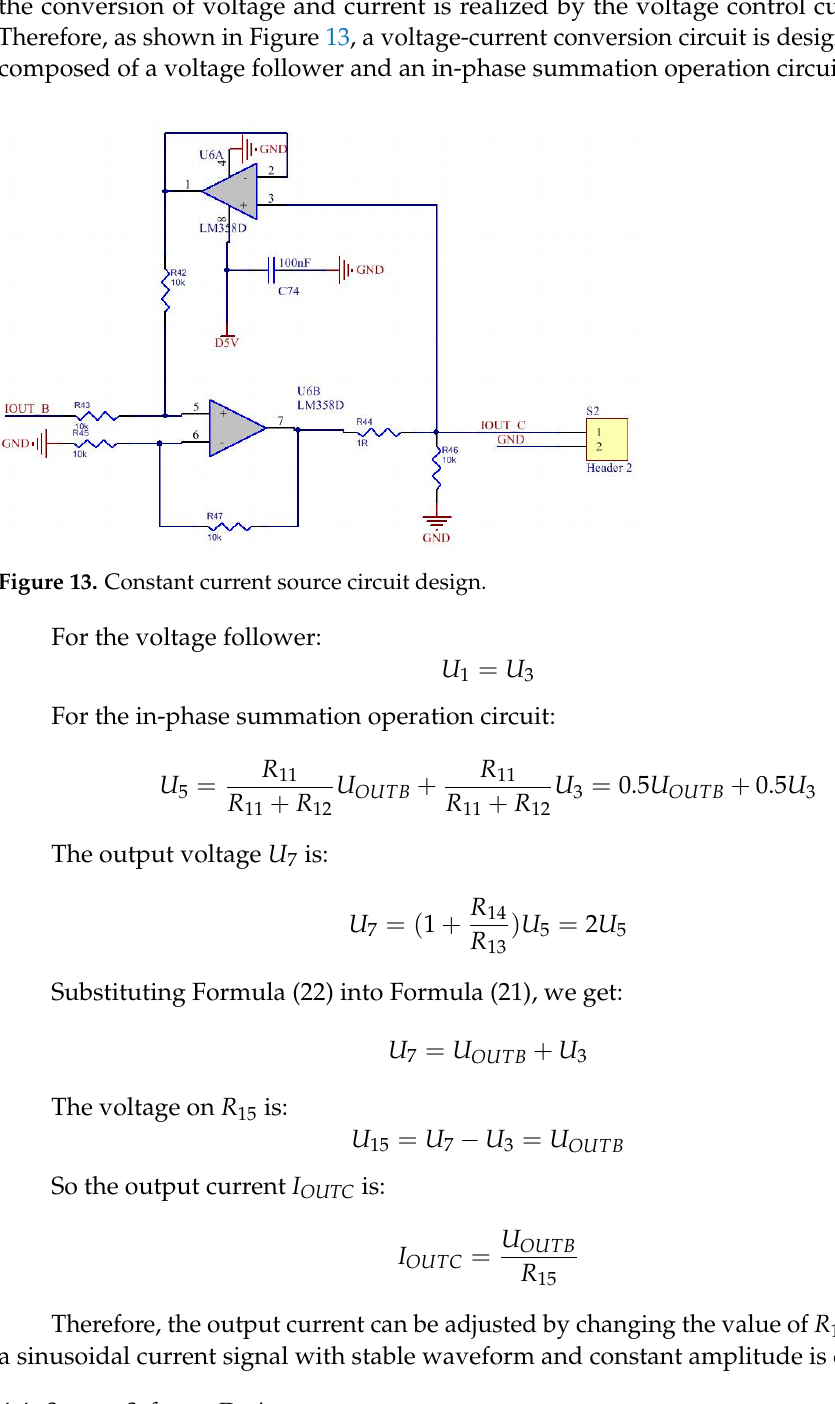
Figure 12. Filter and amplification circuit design.